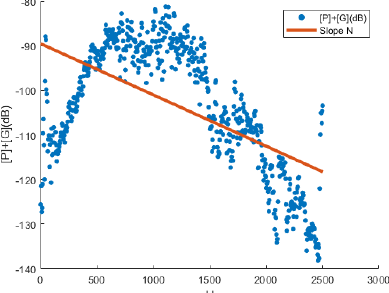
Figure 1 . Scatter diagram composed of H and [ P ] dB + [ G ] dB of a certain A-scan in an echogram in the AGAP region.